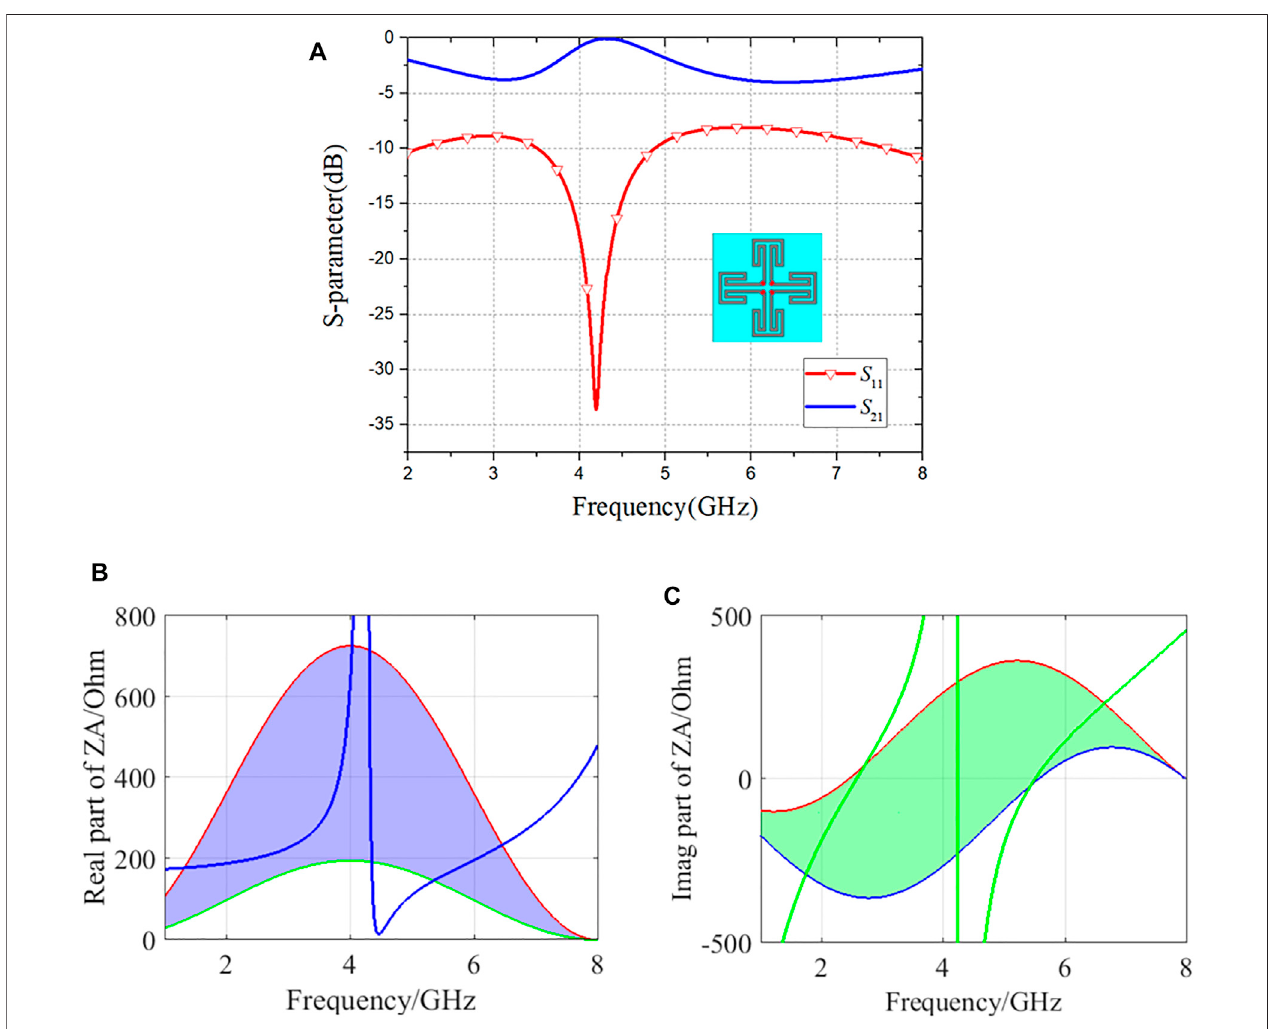
FIGURE 6 | (A) Structure and S-parameter of the lossy FSS. (B) Real part of the impedance. (C) Imaginary part of the impedance.